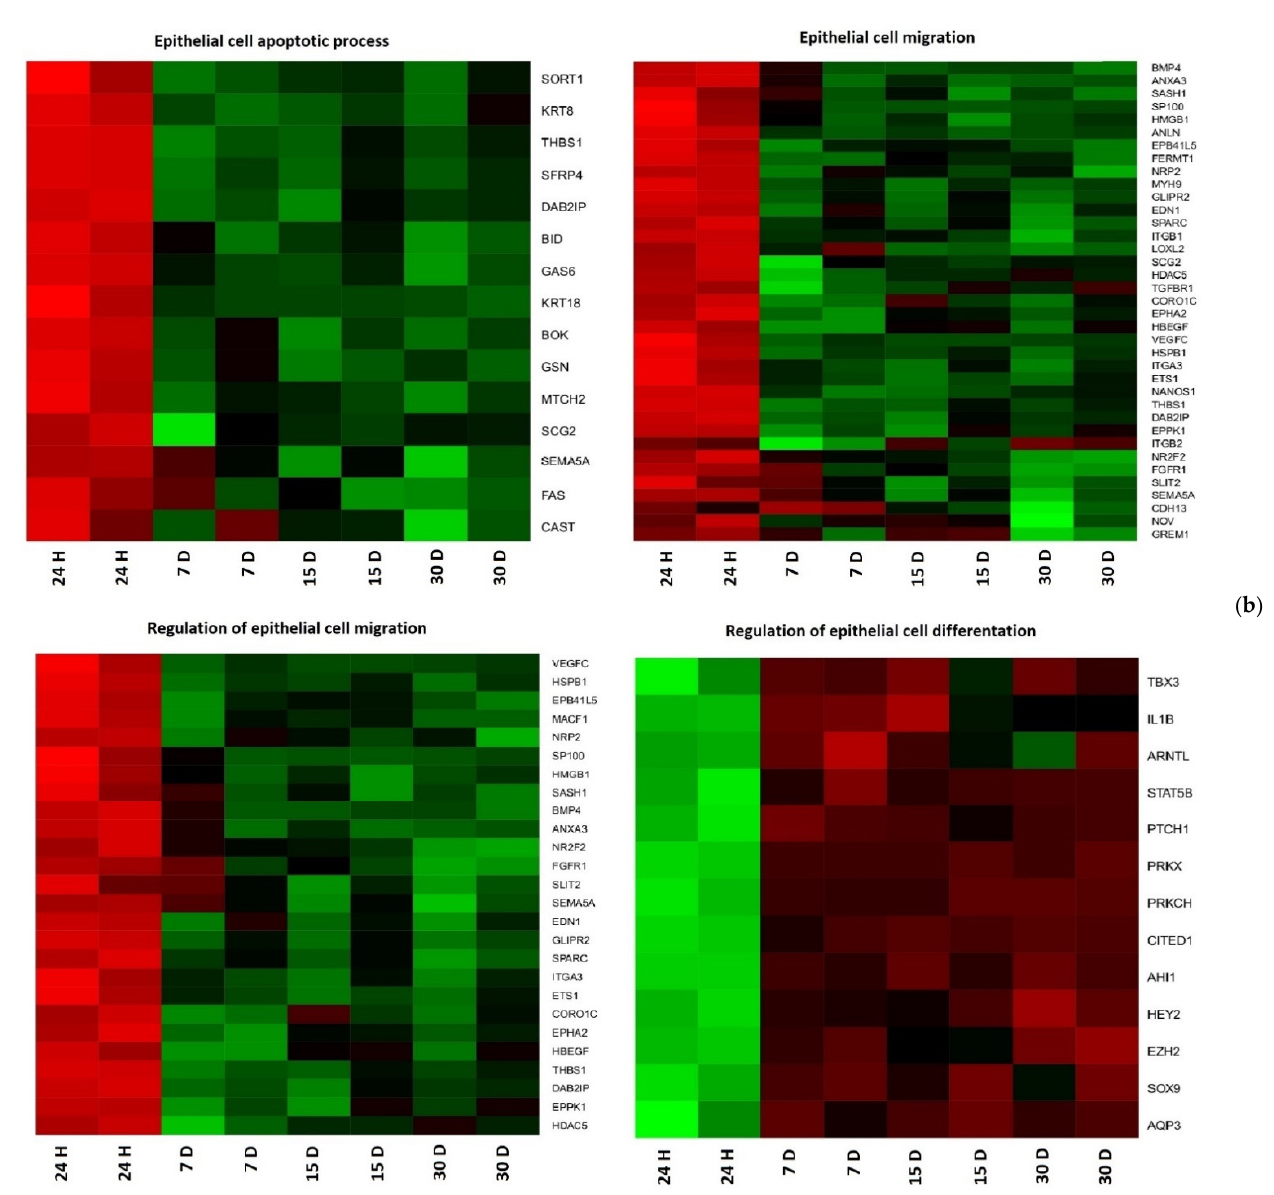
Figure 1. Heat map representation of differentially expressed genes ( a ) CCs; ( b ) GCs. Arbitrary signal intensity derived from microarray analysis is represented by colors (green, higher; red, lower expression). Log 2 signal intensity values for any single gene were resized to Row Z-Score scale (from − 2, the lowest expression to +2, the highest expression for a single gene). The enrichment of each GO BP term was calculated as the z-score and is shown on the circular diagrams (Figure 2).